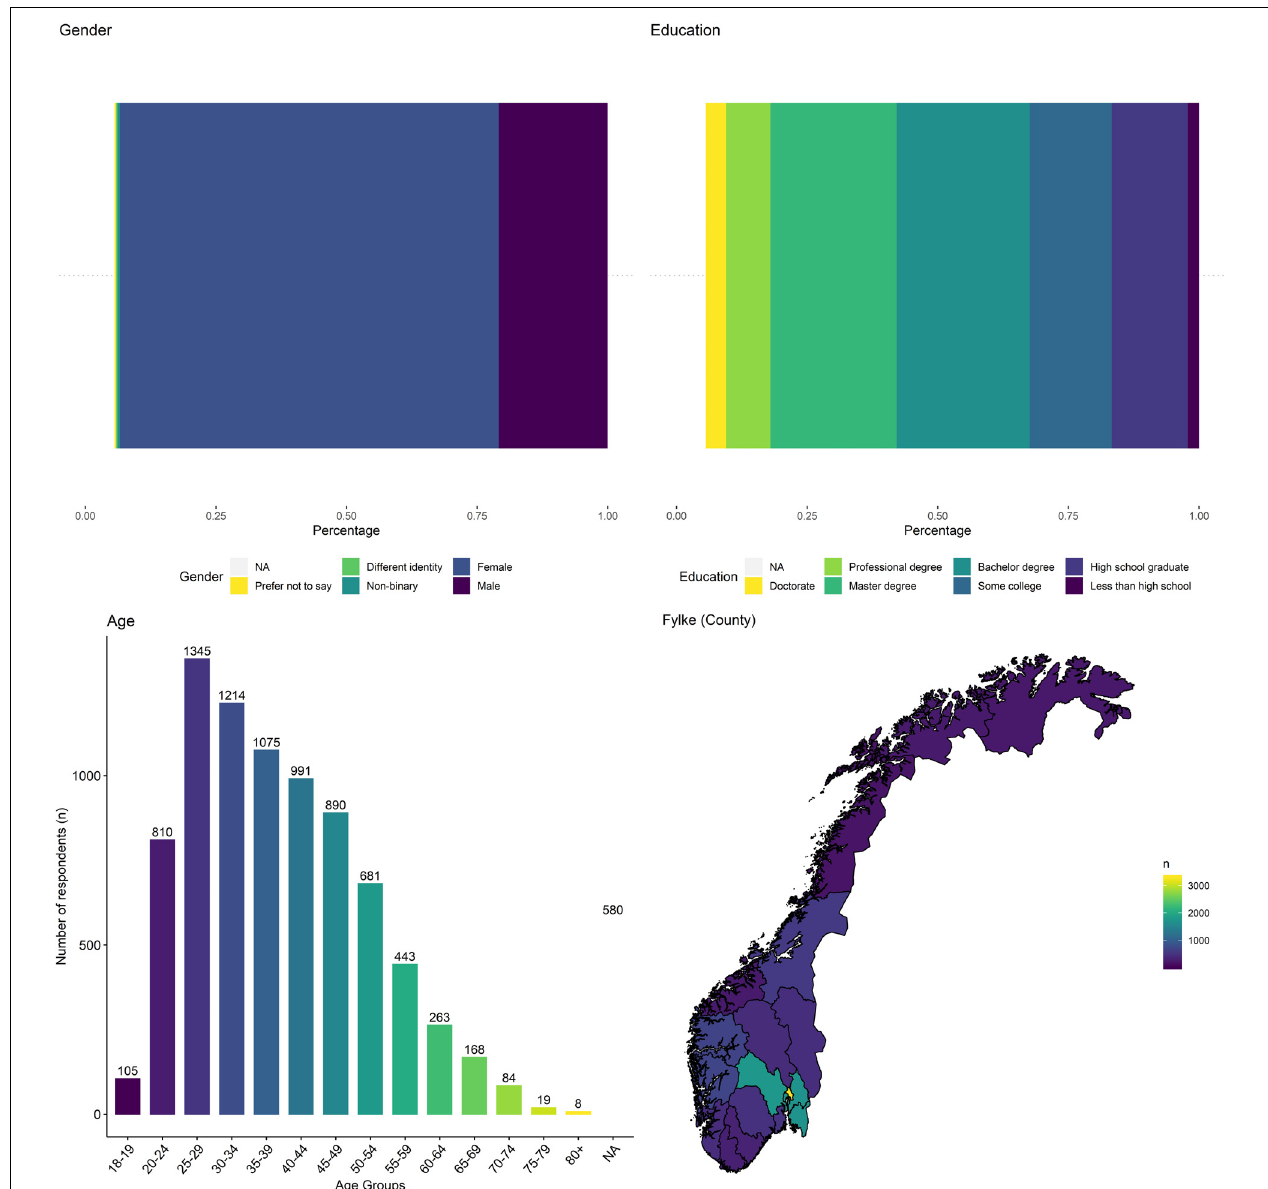
FIGURE 1 | Overview of sample characteristics based on gender, education, age, and